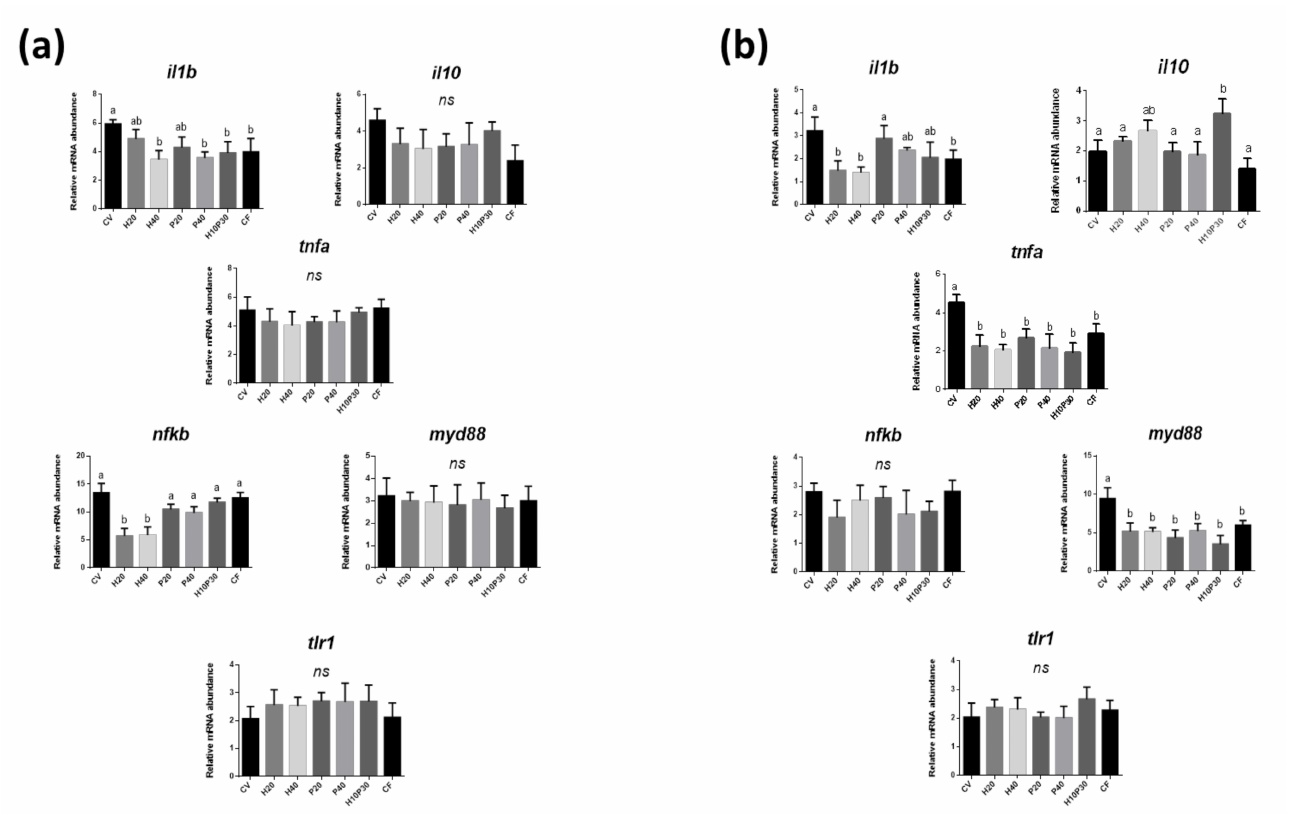
Figure 4. Relative mRNA abundance of genes involved in inflammation and immune response in the medium ( a ) and distal ( b ) intestine. Different letters indicate significant differences among the experimental groups ( p < 0.05); ns = not significant differences. Values are presented as mean ±